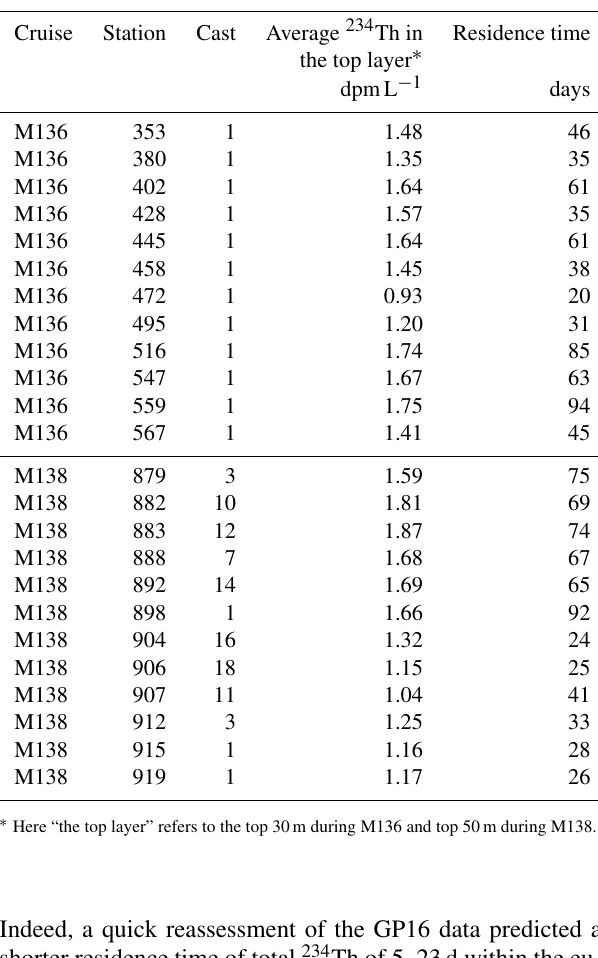
Table 3. Residence time of total 234 Th in the top layers of Peruvian